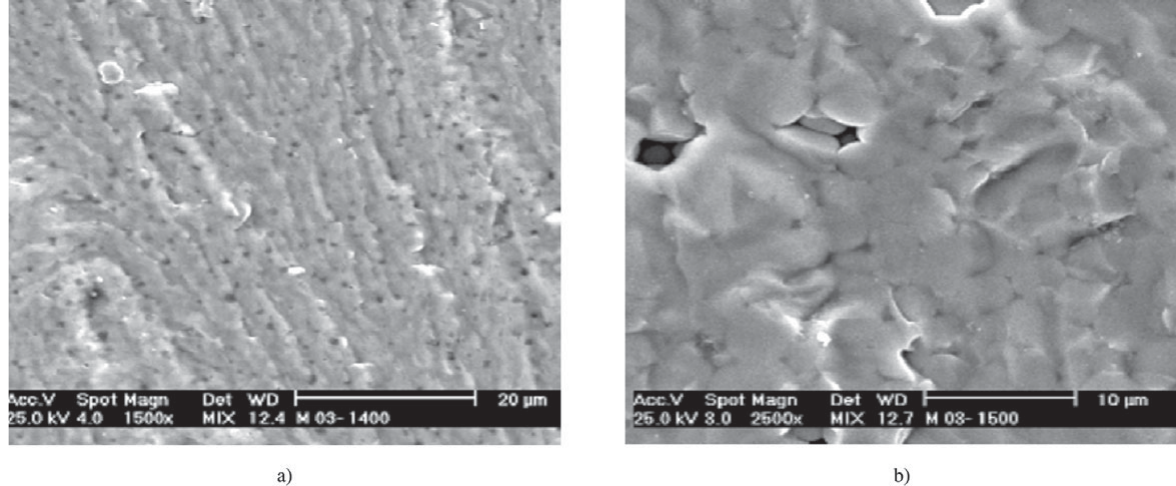
Figure 2. SEM micrographs of samples sintered at 1400 °C/4 h (a); 1500 °C/4 h